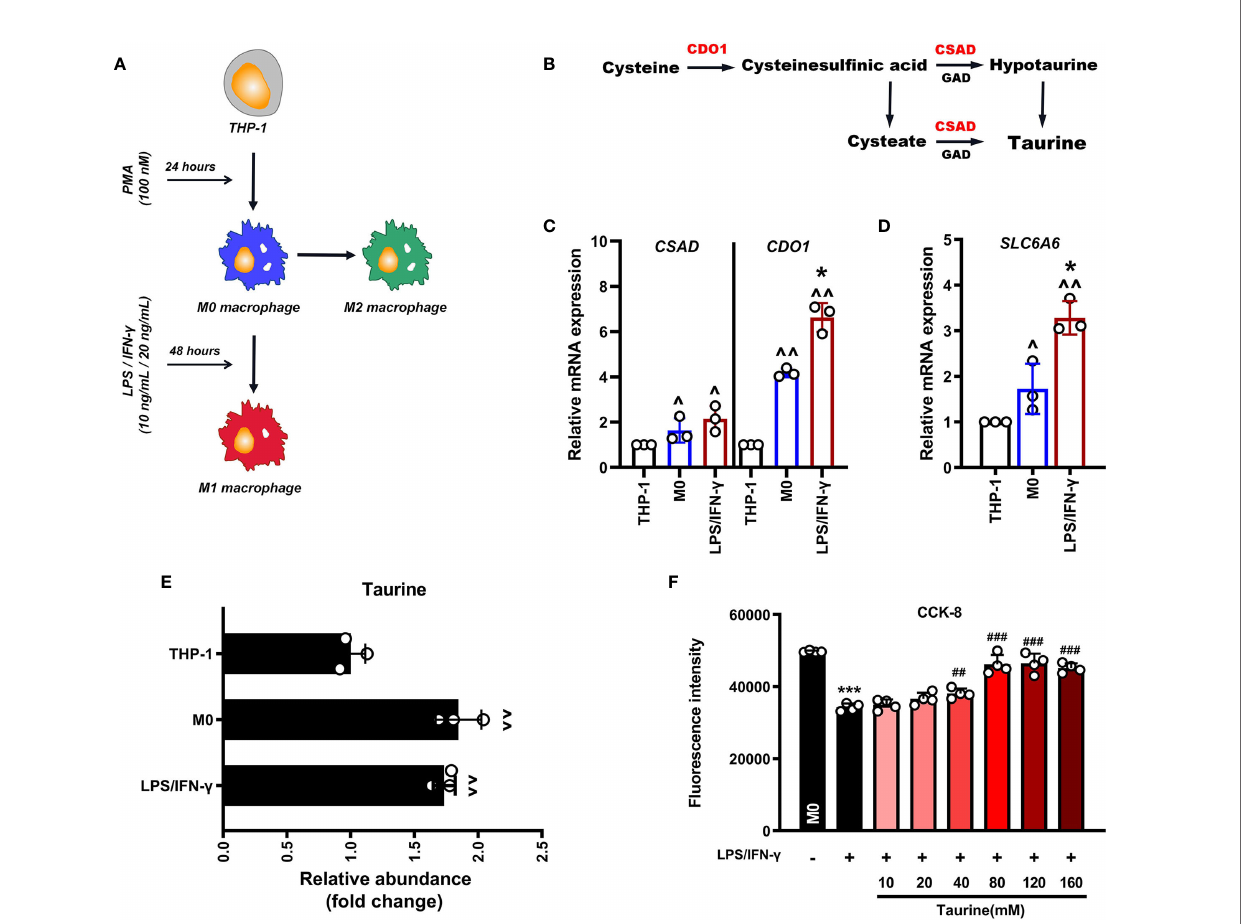
FIGURE 1 | Taurine synthesis and transport are up-regulated at the transcriptional level in LPS/IFN- g -challenged macrophages. (A) Schematic representation of macrophage polarization. (B) Schematic representation of the synthesis of endogenous taurine. (C, D) CDO1 , CSAD , and SLC6A6 mRNA levels in M1 polarization of macrophages, n=3. (E) The abundance of taurine in M1 polarization of macrophages, n=3. (F) CCK-8 analysis in taurine dosage selection, n=4. ^p < 0.05 and ^^p < 0.01 vs. THP-1; *p < 0.05 and ***p < 0.001 vs. M0; ##p < 0.05 and ###p < 0.001 vs. LPS/IFN- g